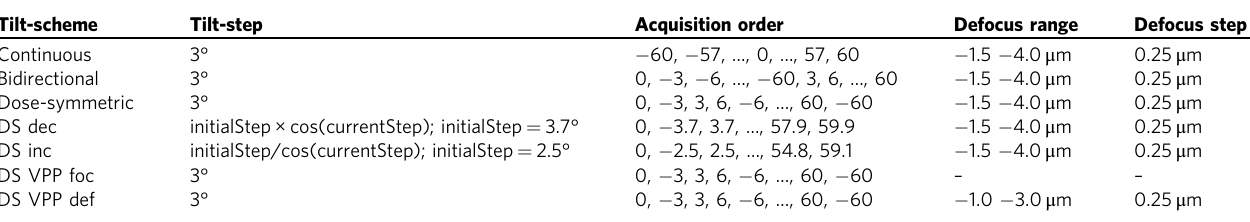
Table 3 Image acquisition parameters that differ for each of the benchmarked schemes. The initial tilt-step for DS dec and DS inc scheme was determined in a way that the whole tilt-series contained 41